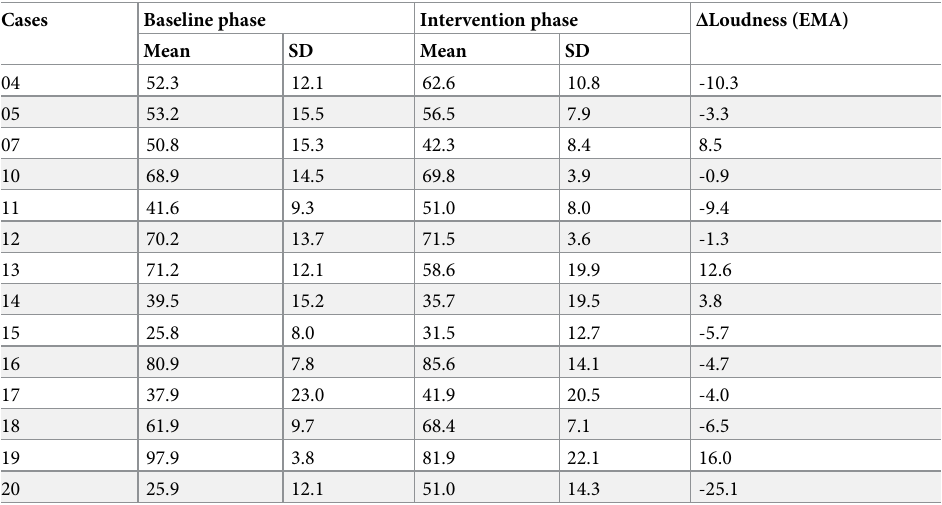
Table 4. Improvement in tinnitus loudness from baseline to end of intervention phase.